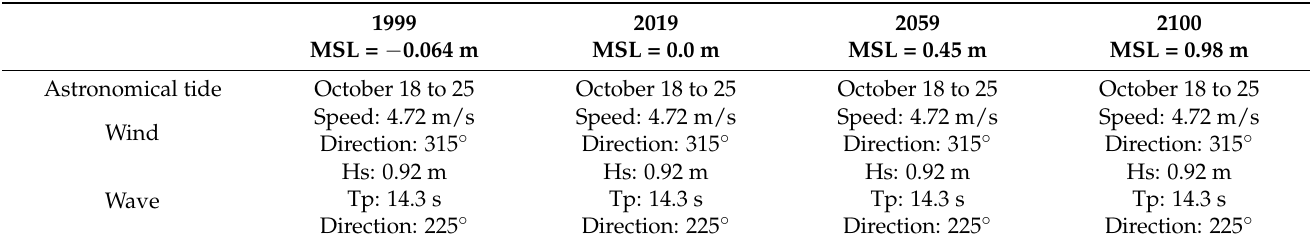
Table 4. Inputs per numerical simulation scenario.